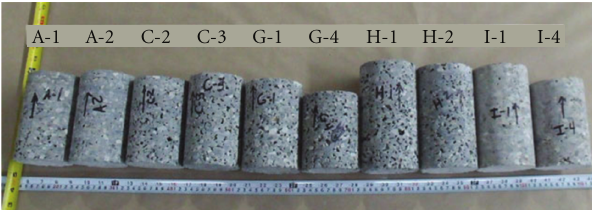
Figure 3: Concrete core samples used for compressive strength evaluation. Note that the length di ff erences are due to uneven pavement thickness.